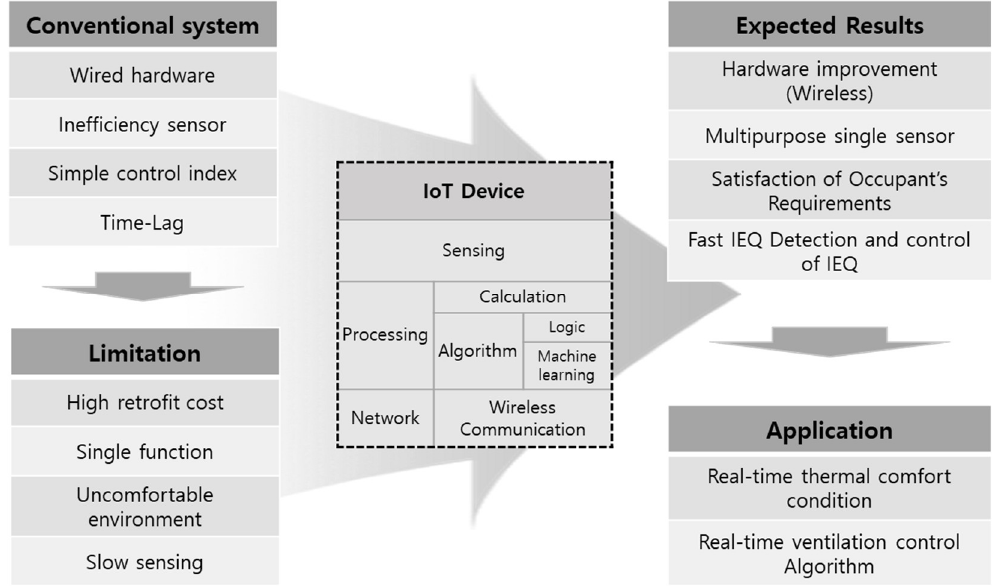
Figure 3. Research